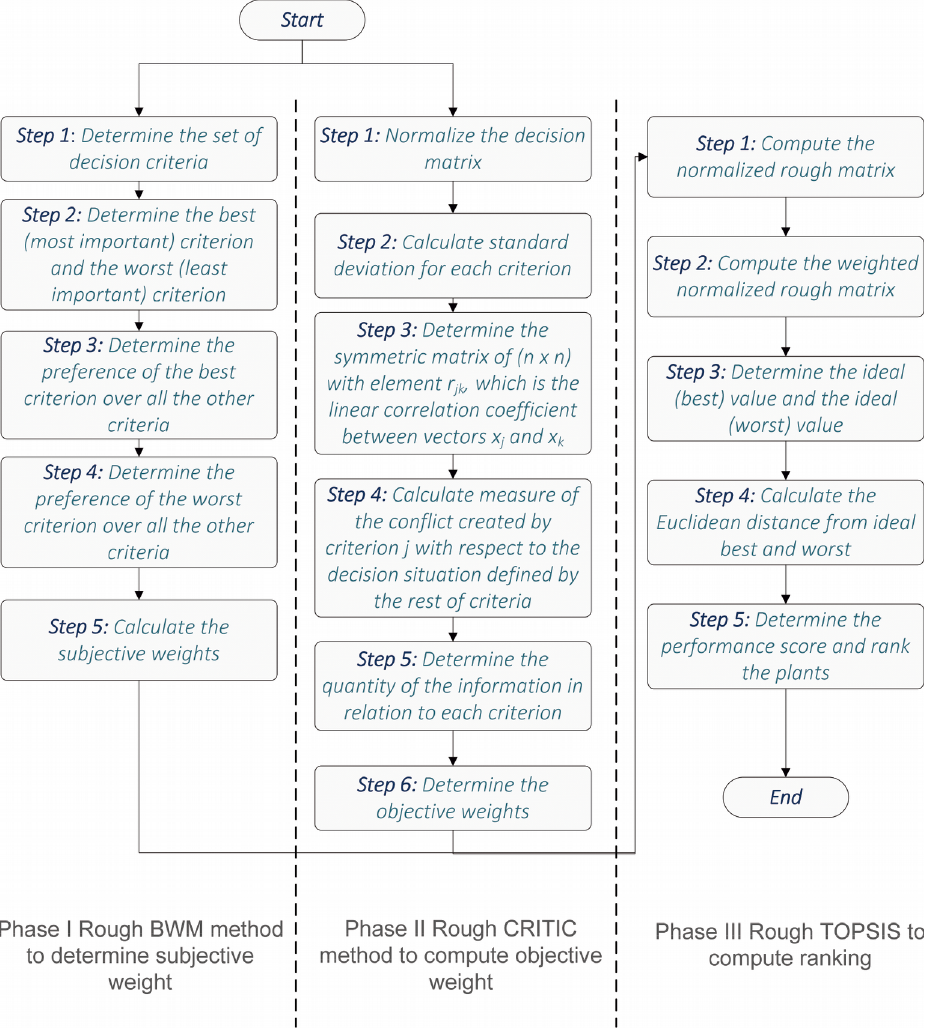
Figure 1. Research